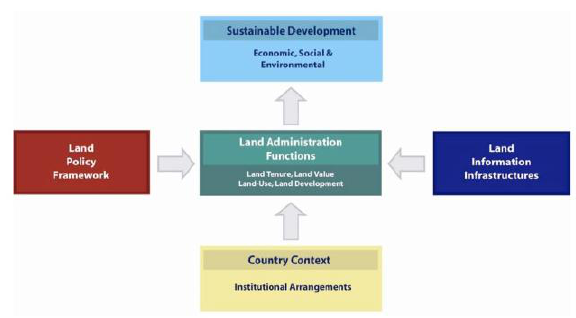
Figure 1. The land management paradigm (Enemark,